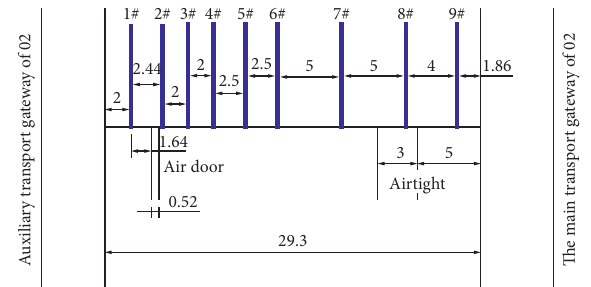
Figure 6: 3# schematic diagram of borehole stressmeter layout in the roadway.